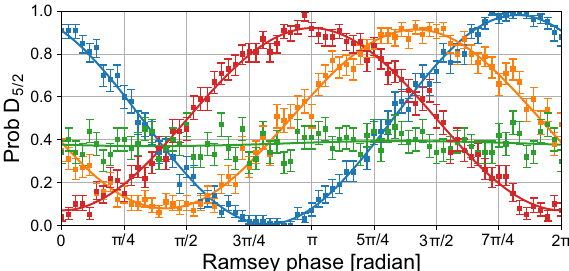
Fig. 4 Ramsey phase scans to verify ion transport. We illustrate a Ramsey measurement of the ion coherence for four cases. The baseline case, with neither shuttling nor probe, is in blue. In orange, the ion is shuttled without a probe at B, showing that coherence is maintained throughout the procedure. To show the probe has no effect when the ion is at A, the ion is held stationary while the probe is turned on (red). Coherence is only lost (green) when the ion is shuttled to B and the probe is turned on. Error bars represent the standard deviation.